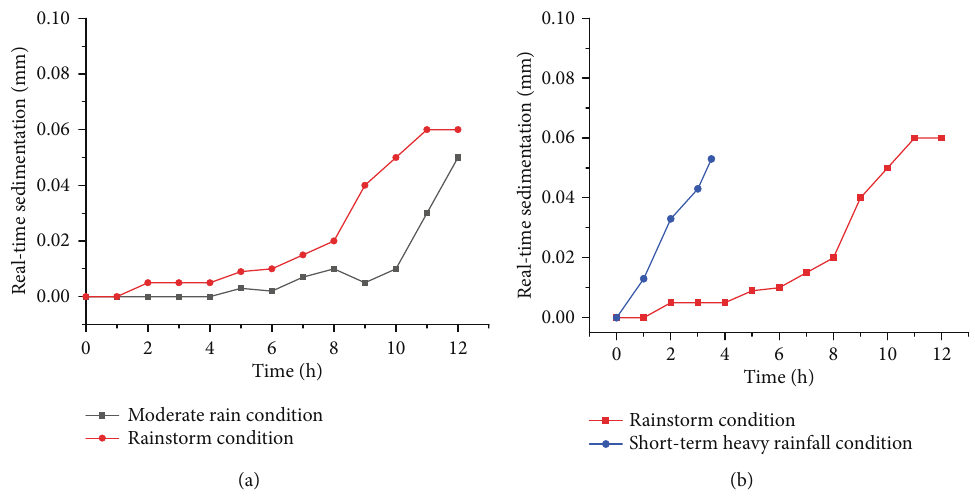
Figure 11: Real-time sedimentation of fi ller under di ff erent rainfall conditions: (a) real-time sedimentation under di ff erent rainfall intensities with the same rainfall duration; (b) real-time sedimentation under di ff erent rainfall intensities with the same rainfall amount.